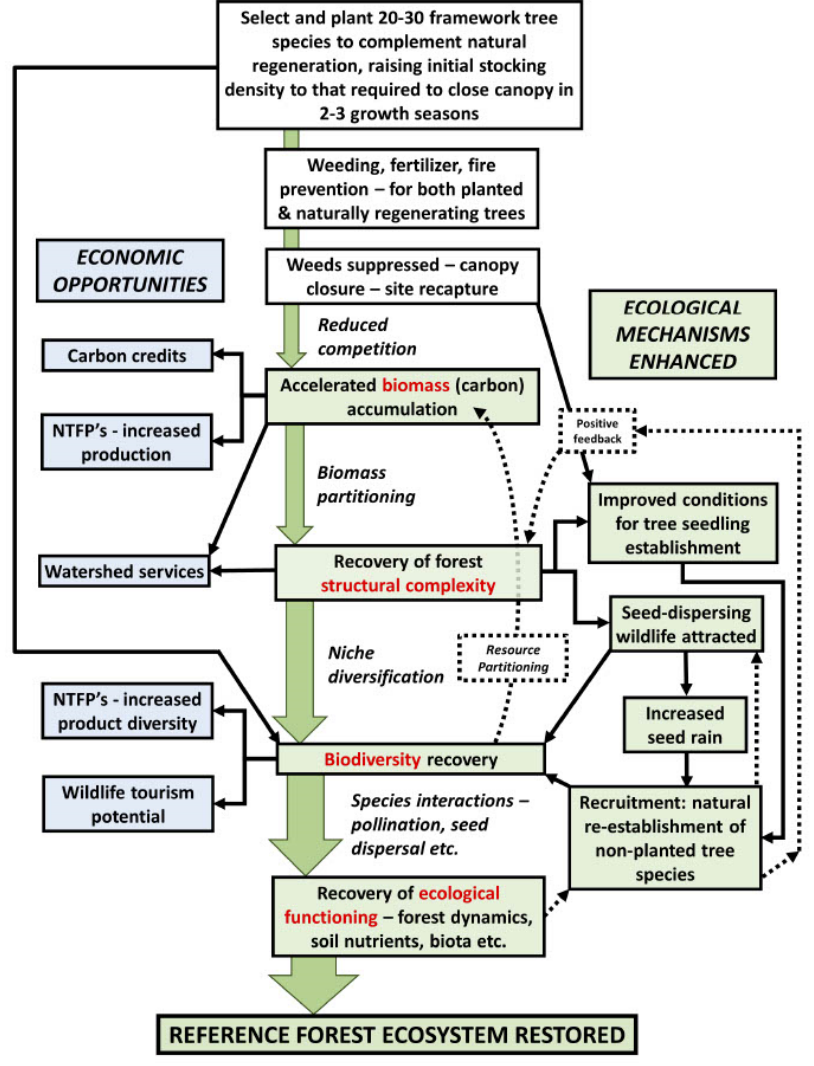
Figure 1. How the framework species method accelerates forest ecosystem restoration. Reprinted with permission from Stephen D. Elliott, first published in Jantawong et al. 2022 [22]. Dotted lines indicate positive feedback loops, by which planted framework tree species intensify key mechanisms of natural regeneration: weed suppression, seed–rain enhancement, and creation of conditions conducive to the establishment of recruit tree species.